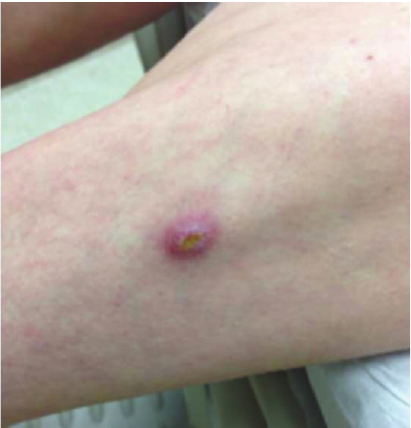
Figure 1: Initial nodule on the thigh that regressed to a small ulcer.